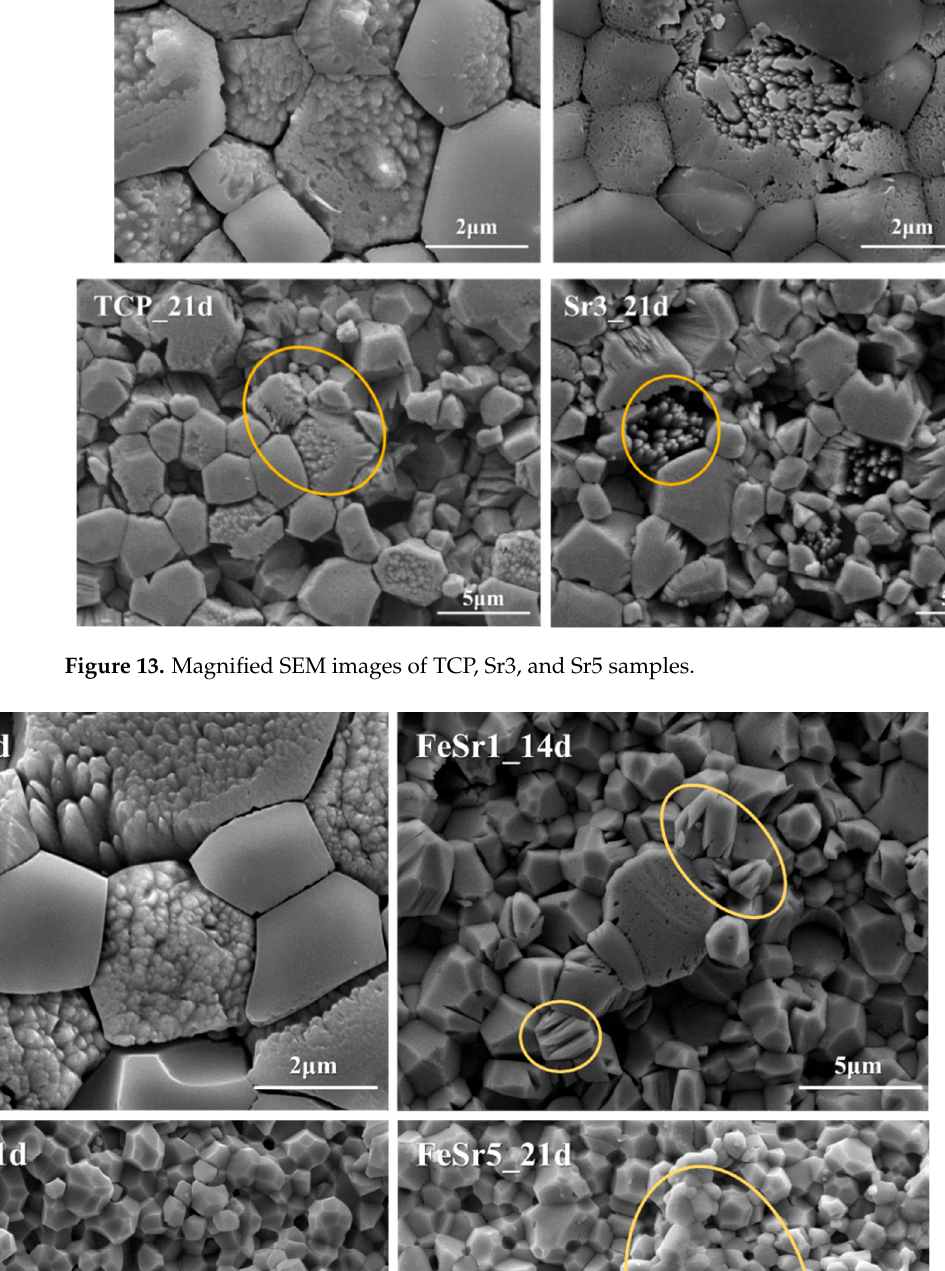
Figure 12. SEM image of disc surface after immersed in TRIS–HCl solution for 14 days.